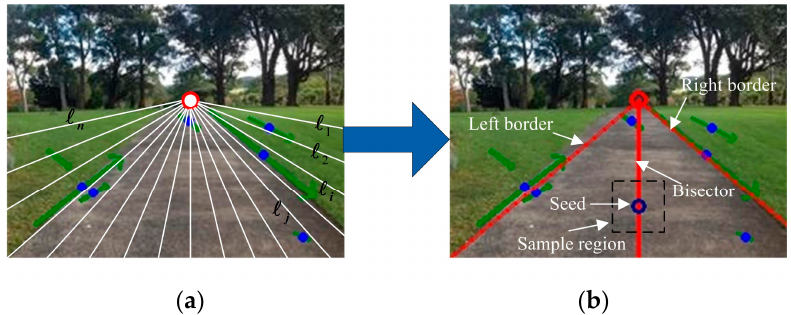
Figure 3. Sample region selection for constructing an appearance model. ( a ) image with 17 evenly distributed imaginary rays (in white) originating from the vanishing point. ( b ) image with dominant borders (in red) and sample region surrounding the seed (blue circle).